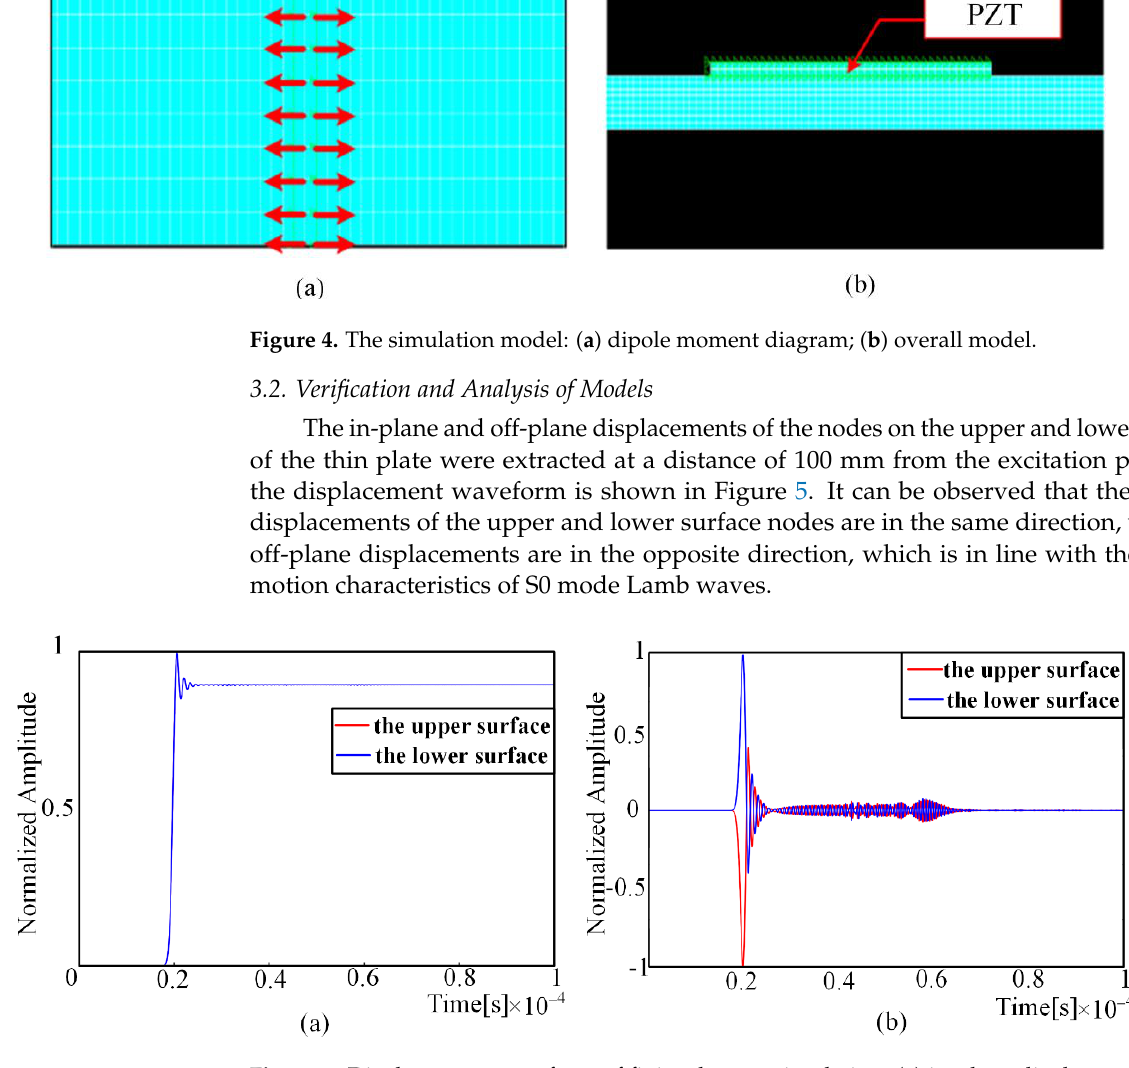
Figure 5. Displacement waveform of finite element simulation: ( a ) in-plane displacement; ( b ) off- plane displacement.